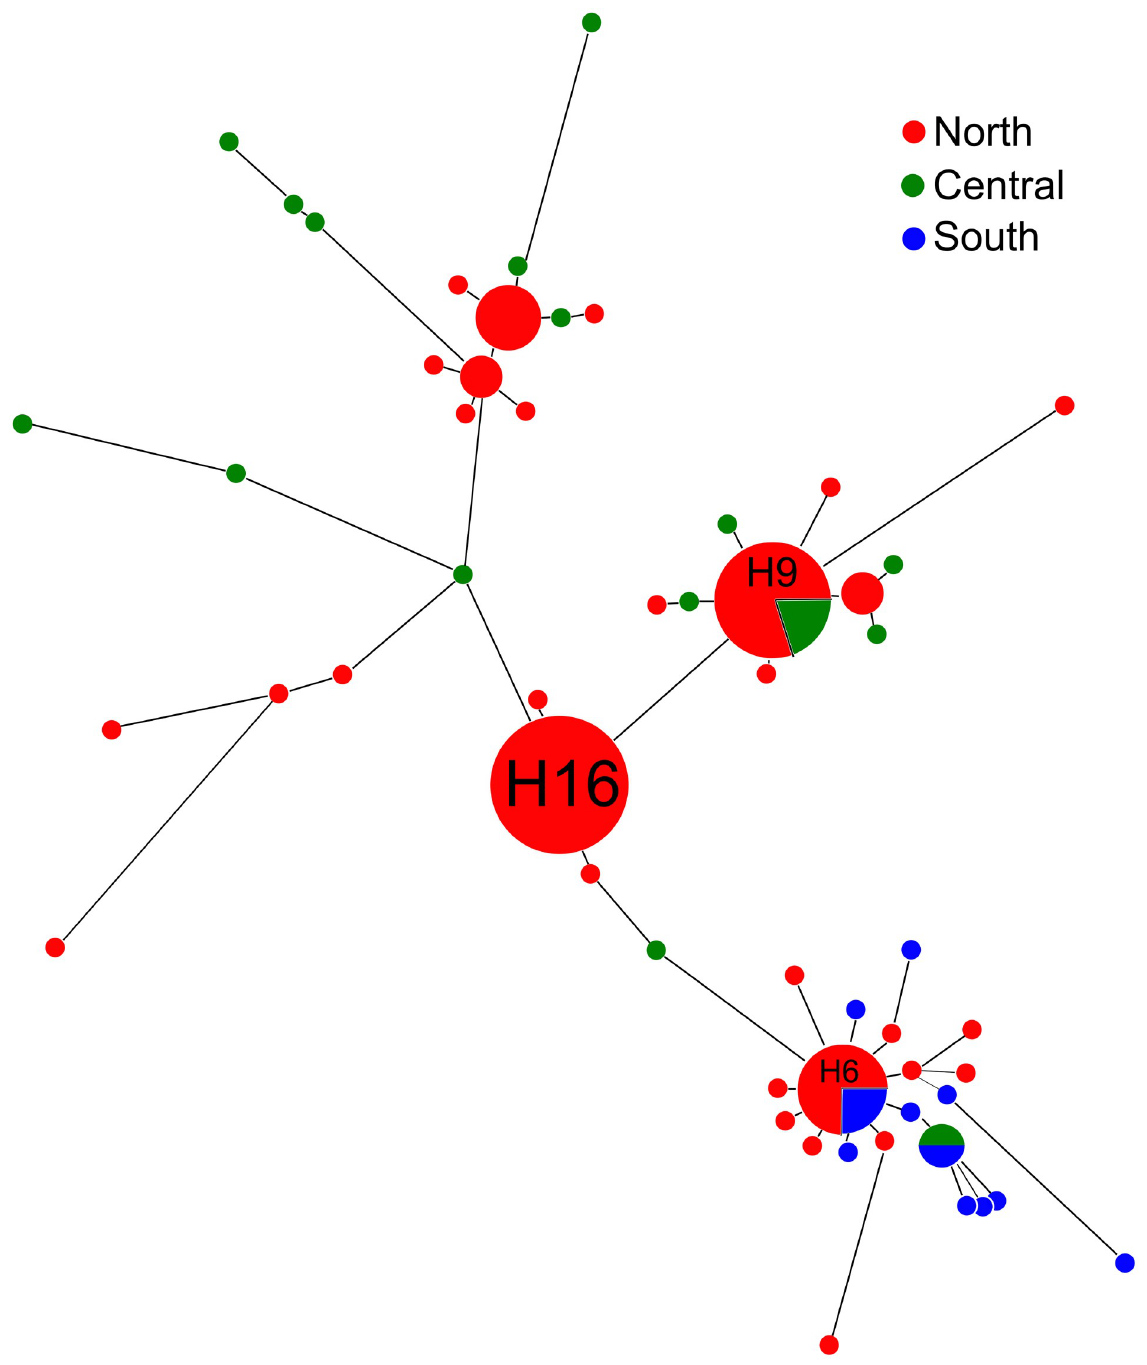
Fig 2. Haplotype network derived from concatenated sequencing data of BT, IGS, ITS, and TEF genes and loci and color-coded for Fusarium oxysporum f. sp. niveum subpopulations: North (Pop1, 44 isolates), central (Pop2, 16 isolates), and south (Pop3, 11 isolates). The connecting lines are proportional to number of mutations between isolates.